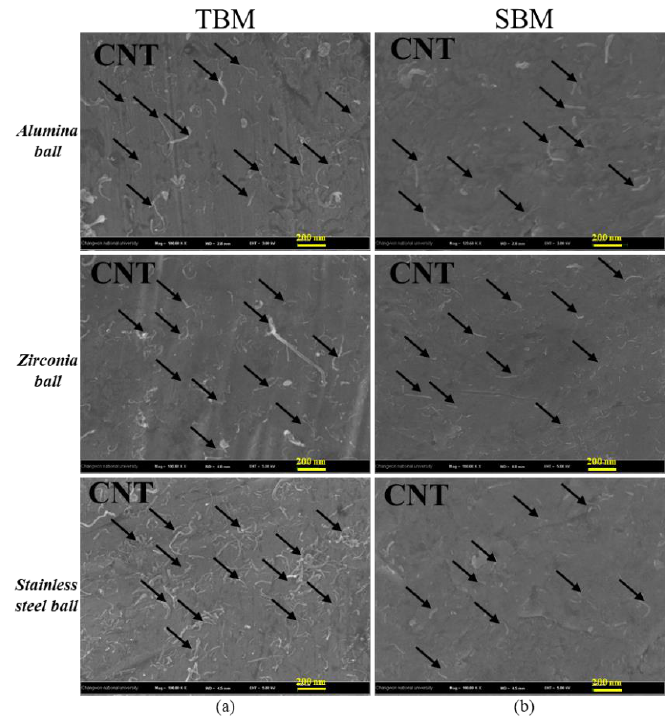
Figure 10. FESEM images (100,000 × ) of Cu / CNT nanocomposites for 12 h at 300 rpm in both mills ( a ) TBM and ( b ) SBM with three different milling media.